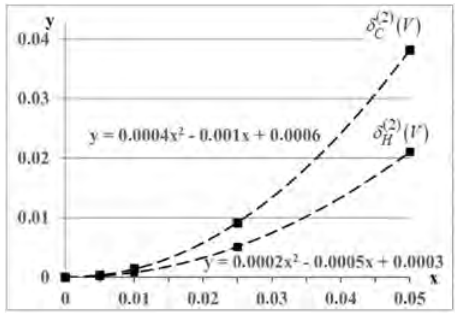
( V ) , - - - graphs of ( V ) , δ (1) C H